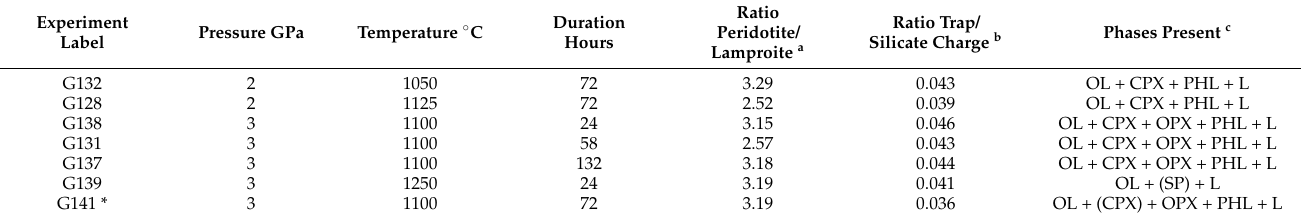
Table 1. Experimental details for dynamic metasomatism experiments.